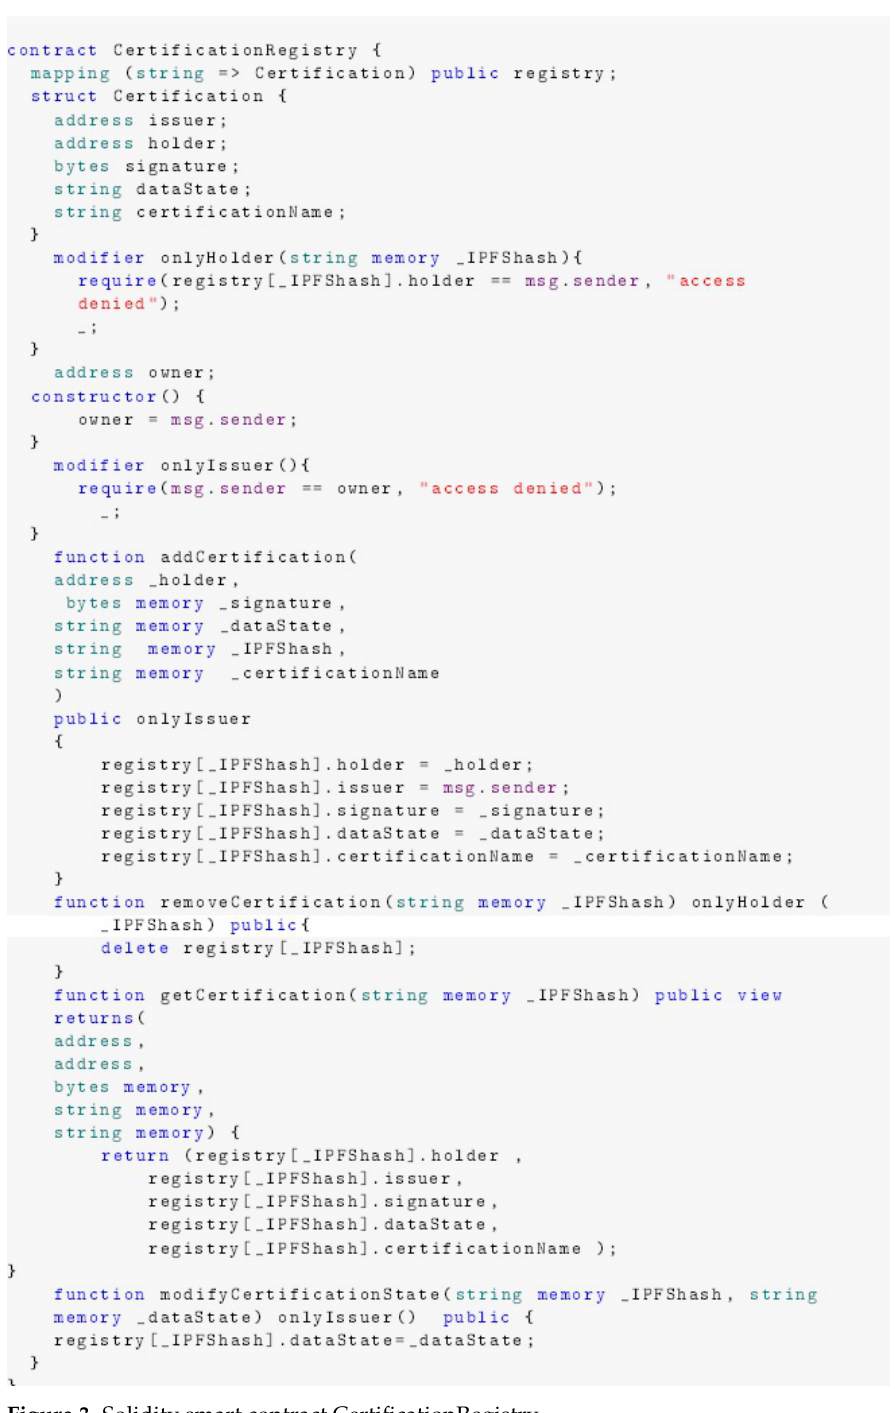
Figure 3. Solidity smart contract